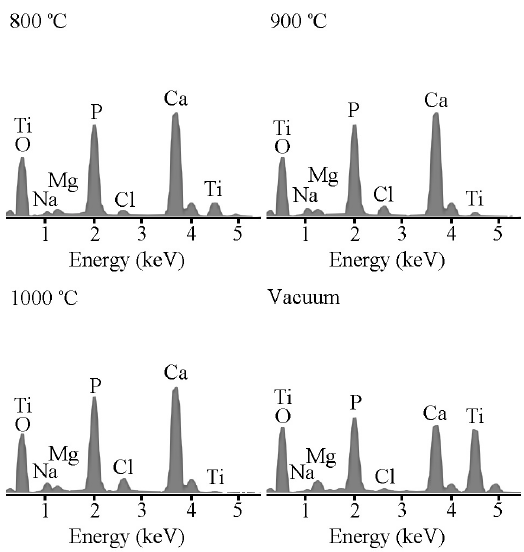
Figure 6. Energy-dispersive X-ray spectroscopy (EDS) results for Ti samples sintered at 800, 900, and 1000 °C in air and for a Ti sample sintered in vacuum after immersion in SBF for 21 days. FTIR spectra of all sintered Ti samples that were immersed in SBF for 21 days are displayed in Figure 7. The four samples have similar FTIR spectra, indicating that their Ca–P coating layers had the same functional groups. Bands assignable to OH − , PO 43 − , CO 32 − , HPO 42 − , and H 2 O are present. These results suggest that all of the coating layers have carbonate-substituted calcium phosphates.